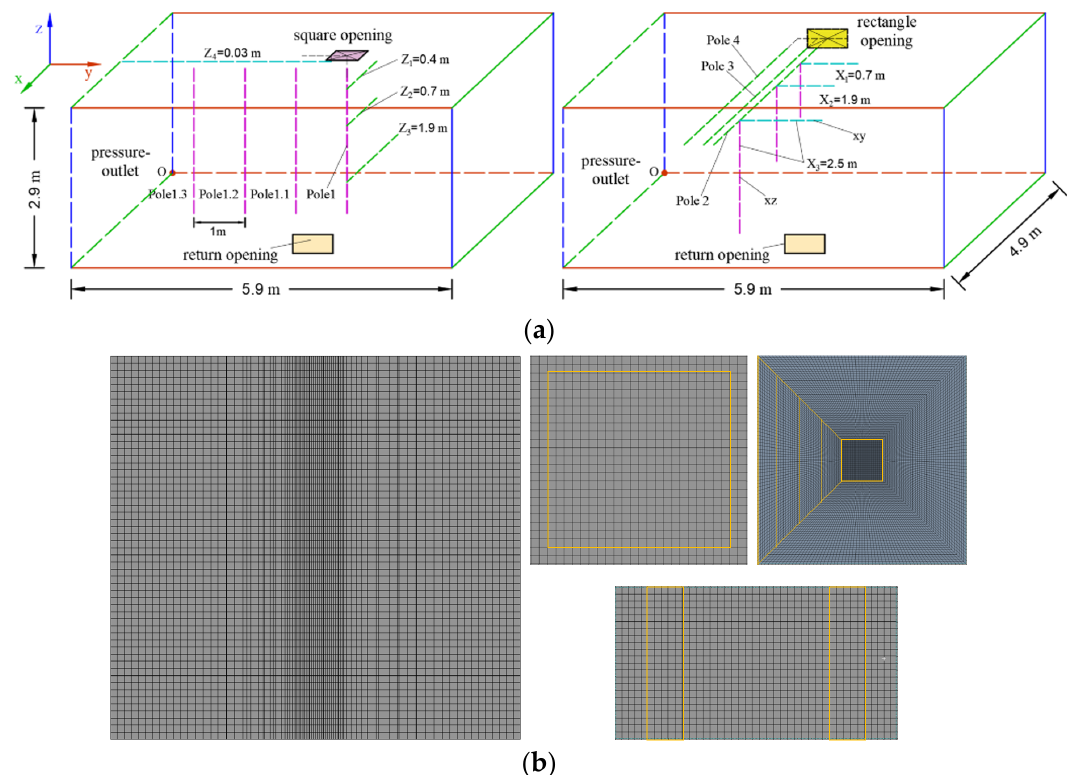
Figure 5. The computational physical model and mesh. ( a ) Layout of the physical model; ( b ) the computational mesh.